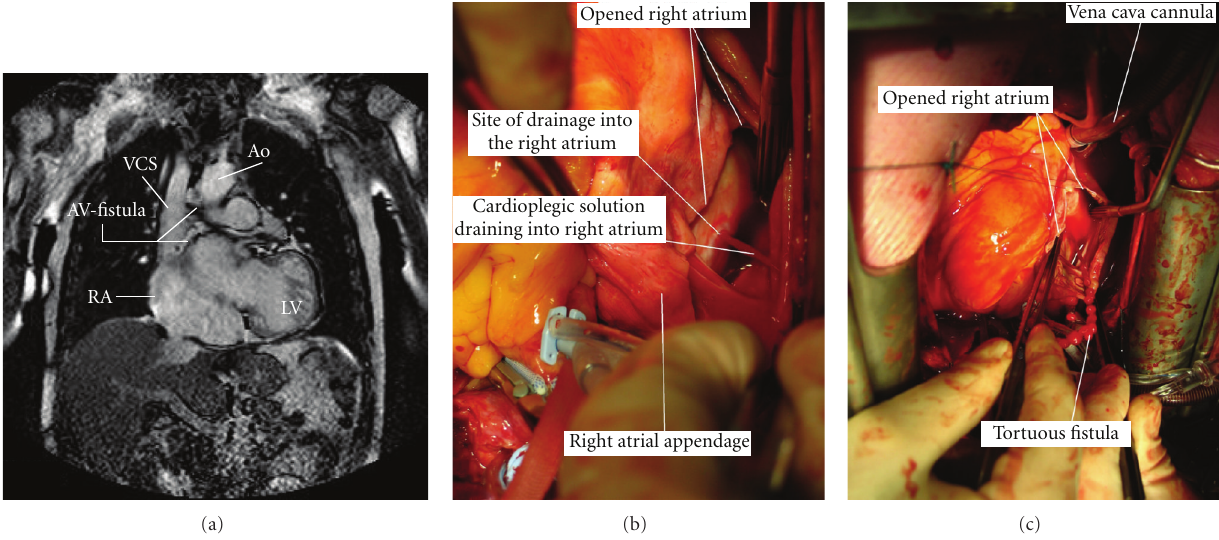
Figure 3: (a) A MRI image showing the arteri-venous malformation originating from the left coronary sinus and draining into the right atrium. Ao = aorta. VCS = vena cava superior. AV = arterio-venous. RA = right atrium. LV = left ventricle. (b) Intra operative image with the site of drainage into the right atrium. (c) Intra-operative image showing the very tortuous arterio-venous